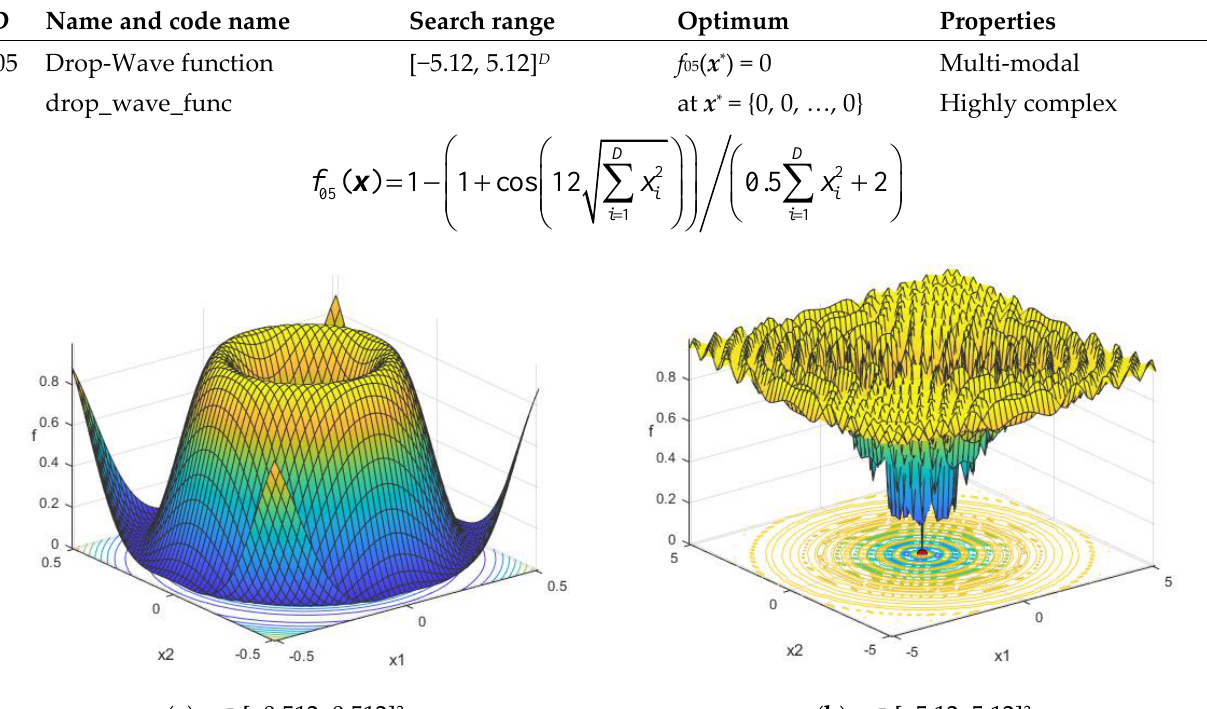
Figure A5. Drop-wave function in two dimensions.